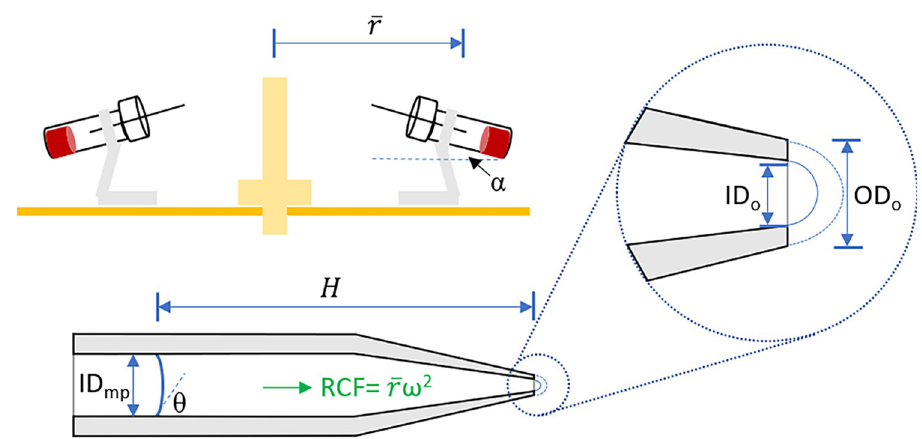
Fig 3. Schematics of the micropipette parameters for cyt-B centrifugal